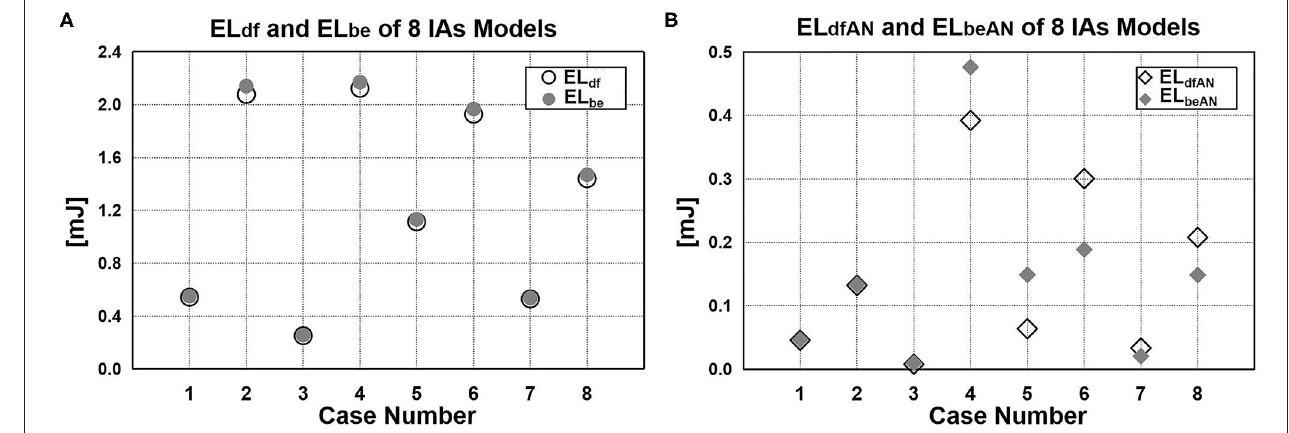
FIGURE 8 | EL value calculated by DF-based and Bernoulli equation–based method. (A) Difference between EL df and EL be . (B) EL of aneurysm sac: EL dfAN and EL beAN